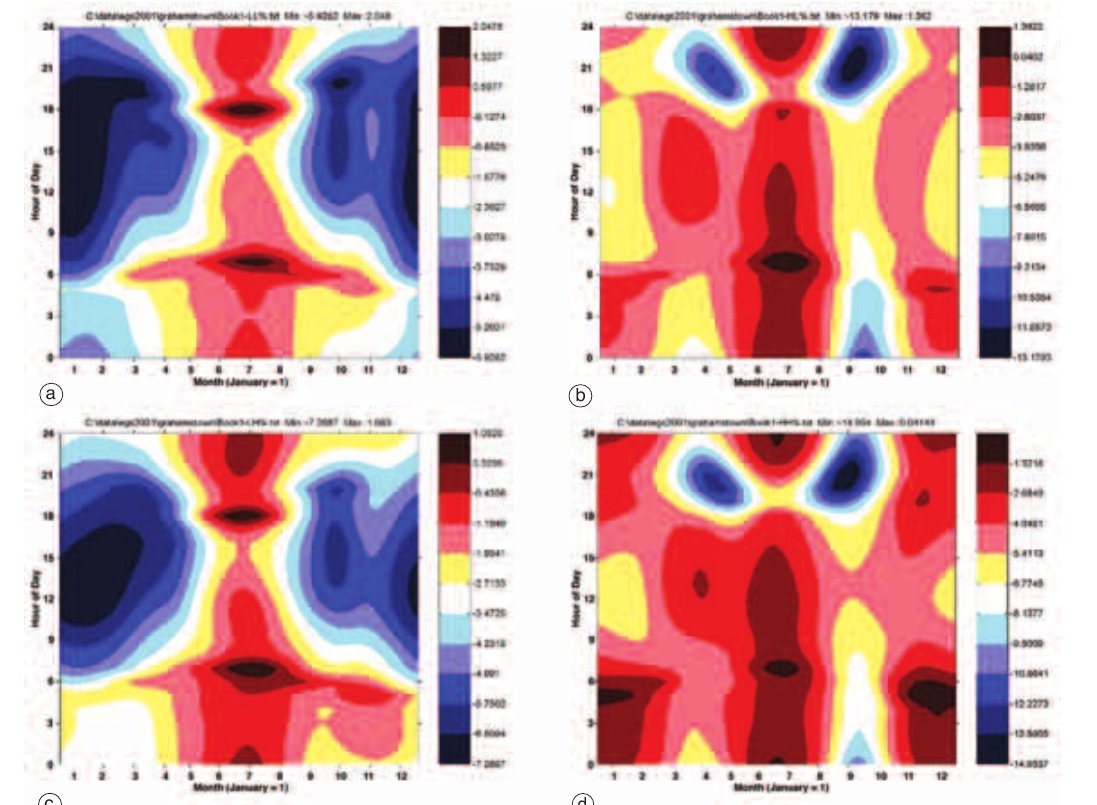
c Fig. 4a-d. Contour maps of the function (cid:54) ƒ